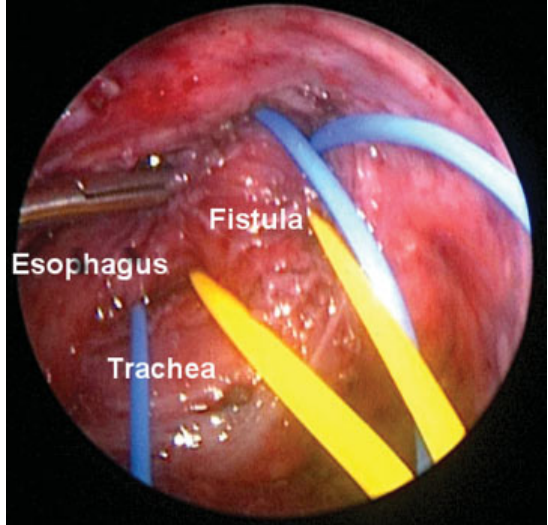
Fig. 2 Intraoperative image of the thoracoscopic reclosure of the fi stula. The recurrent fi stula is retracted with the yellow loop, the esophagus with the blue